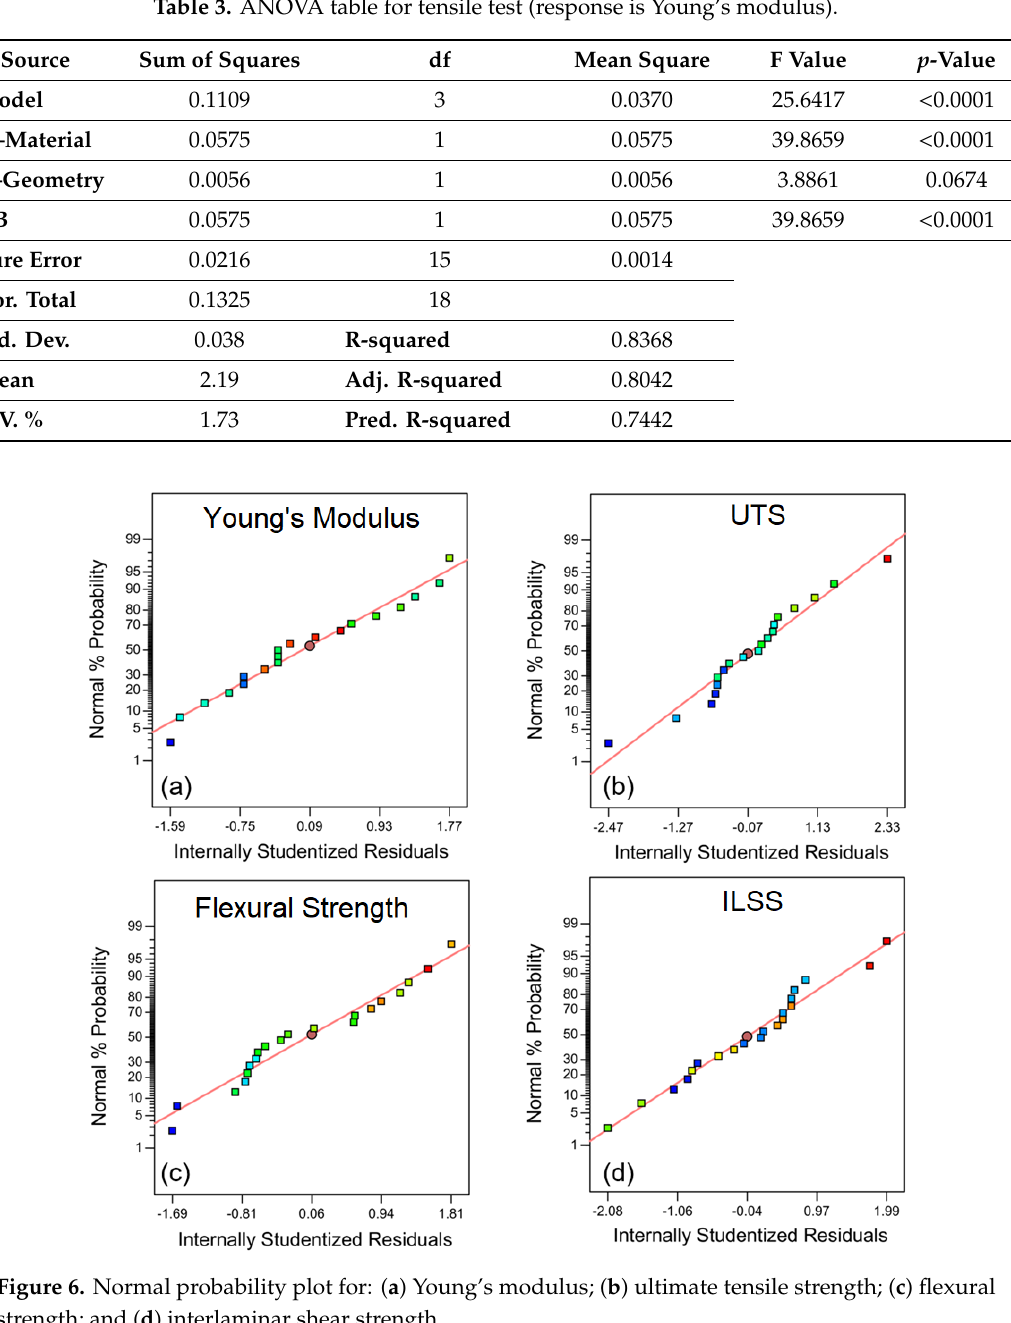
Figure 7. Normal probability plot for tensile test (Young’s modulus).